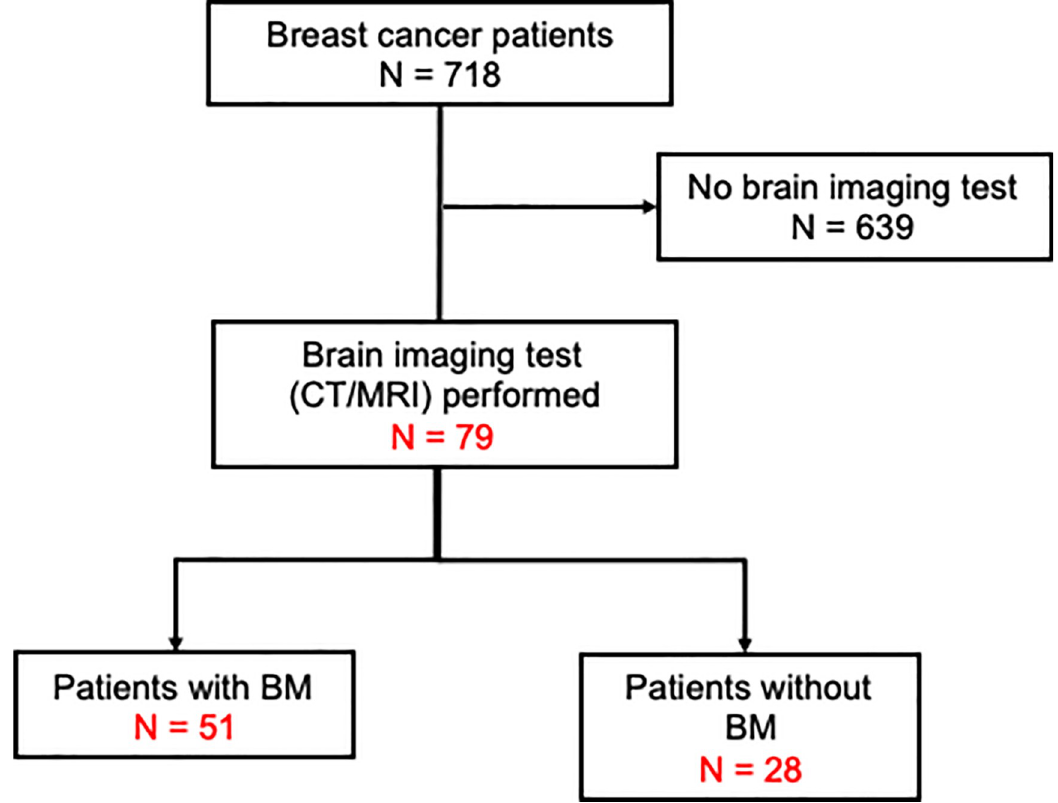
Fig 1. Consort diagram of the present study. CT/MRI, computed tomography/magnetic resonance imaging; BM, brain metastasis.